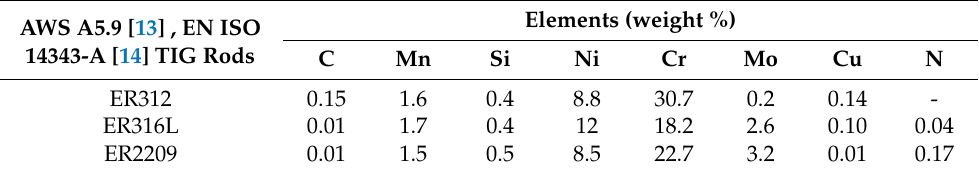
Table 2. Elemental production analysis values of TIG welding